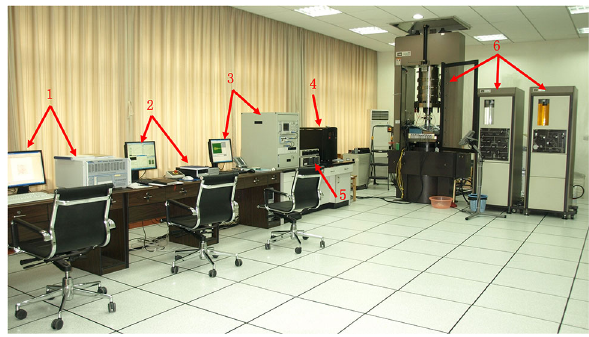
Fig. 1 MTS815 Rock Test System, which comprises six subsystems: 1—an acoustic three-dimensional positioning and collection system; 2—an MTS815 process control and acquisition system; 3—an ultrasonic excitation and acquisition system; 4—an MTS815 control center; 5—a high-temperature control system; 6—a loading system (axial, seepage, and confining